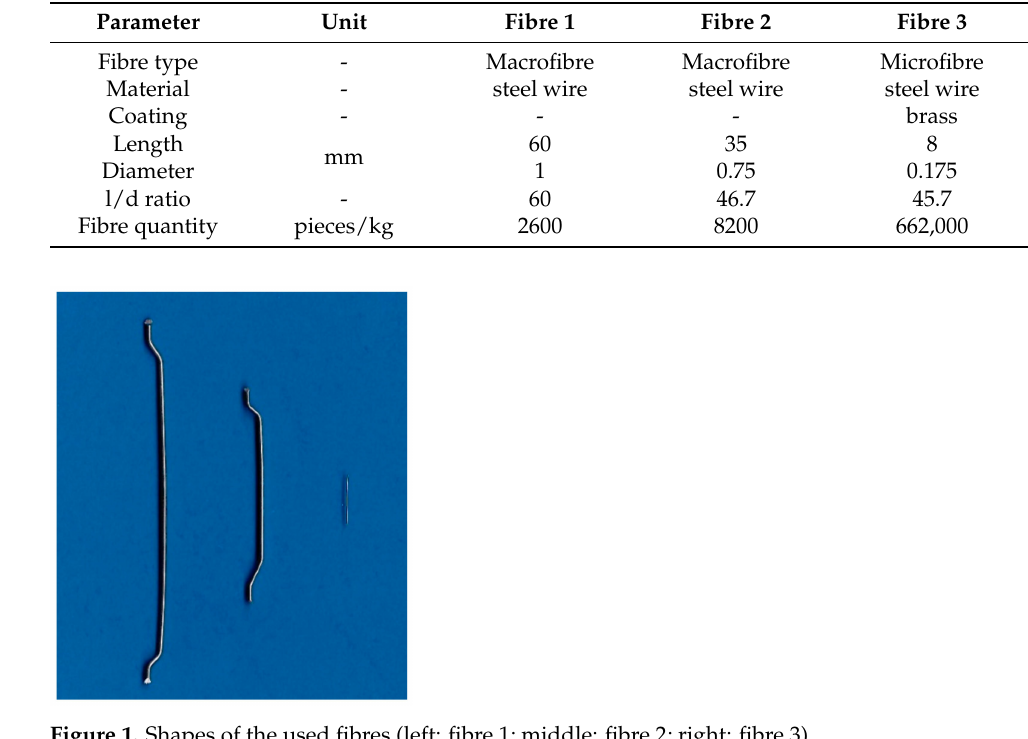
Figure 1. Shapes of the used fibres (left: fibre 1; middle: fibre 2; right: fibre